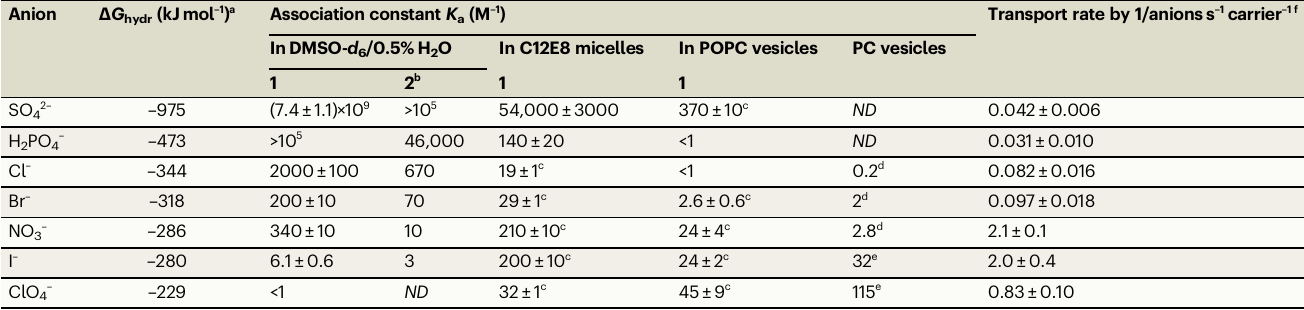
Table 1 | Anion binding and transmembrane anion transport properties of compound 1, along with literature values of anion hydration free energies and anion binding properties of compound 2 and PC vesicles Anion Δ G hydr (kJmol – 1 )